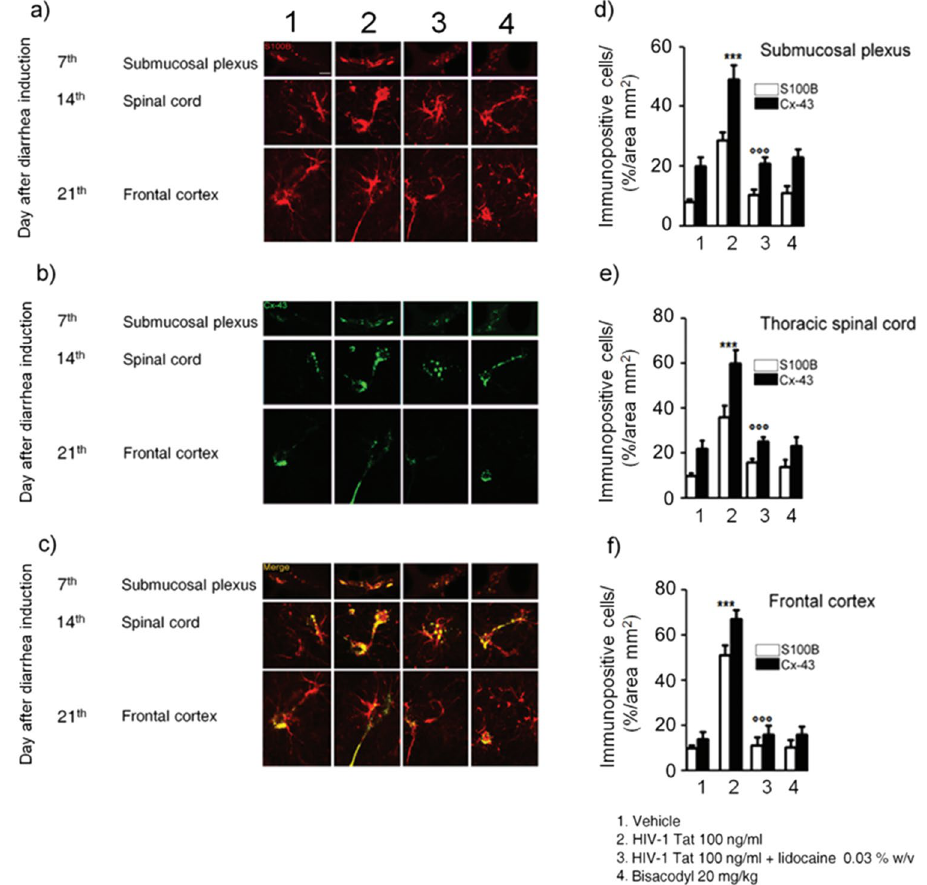
Figure 5. ( a – c ) Intracolonic administration of HIV-1 Tat caused a marked increase of Cx-43 (green) protein expression in S100B-positive cells (red) in the submucosal plexus, spinal cord and frontal cortex, respectively. ( d – f ) Quantitative analysis revealed that administration of lidocaine significantly reduced Cx-43 expression on S100B-positive cells of HIV-1 Tat group, whereas bisacodyl did not produce any change in Cx-43 expression compared to vehicle group (S100B (open bars) and Cx-43 (filled bars) expression in the analyzed areas. *** p < 0.001 vs all other groups; °°°p < 0.001 vs HIV-1 Tat group. Scale bars: 20 μ m; n = 6 for each